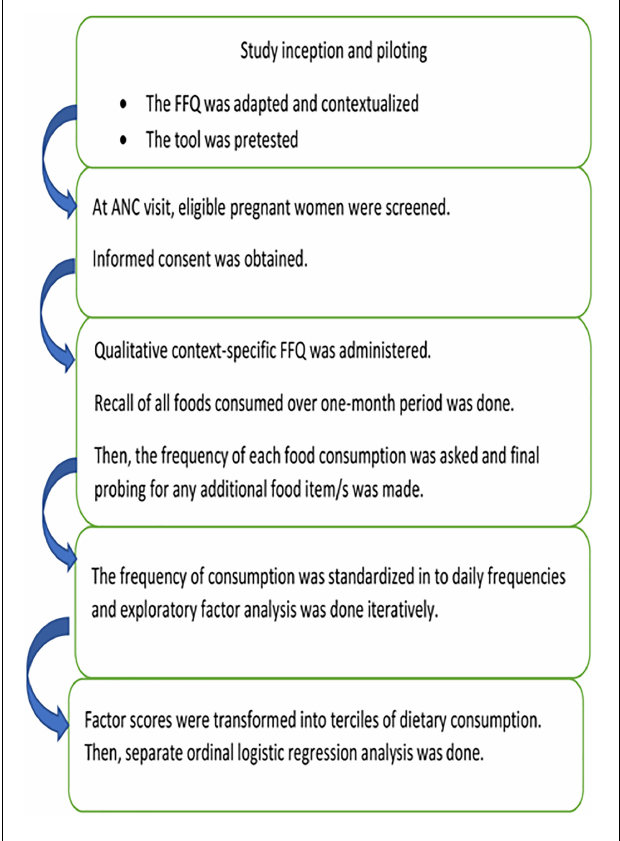
FIGURE 1 | Flowchart showing overview of the study procedures, from inception and final report.